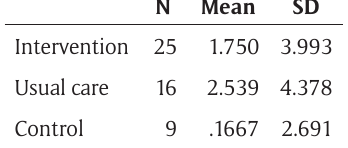
Table 5: Comparison of the mean and standard deviation (SD) Variation in Readiness to Change (T2-T1) scores between groups.